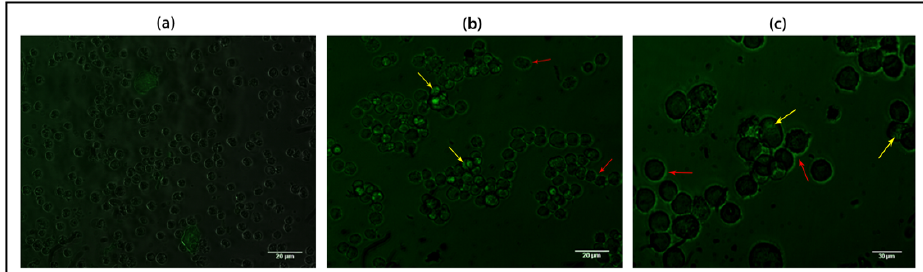
Figure 8. Metastatic melanoma cells (WM-266-4) incubated with 0.3 μ M of ( a ) GFP; ( b ) MLB + GFP and ( c ) SNA + GFP for 24 h and screened under luminescence imaging microscopy. The RED arrows show the attachment of the fusion proteins to the cell membranes and cell agglutination. The YELLOW arrows show cell internalization of the fusion proteins.